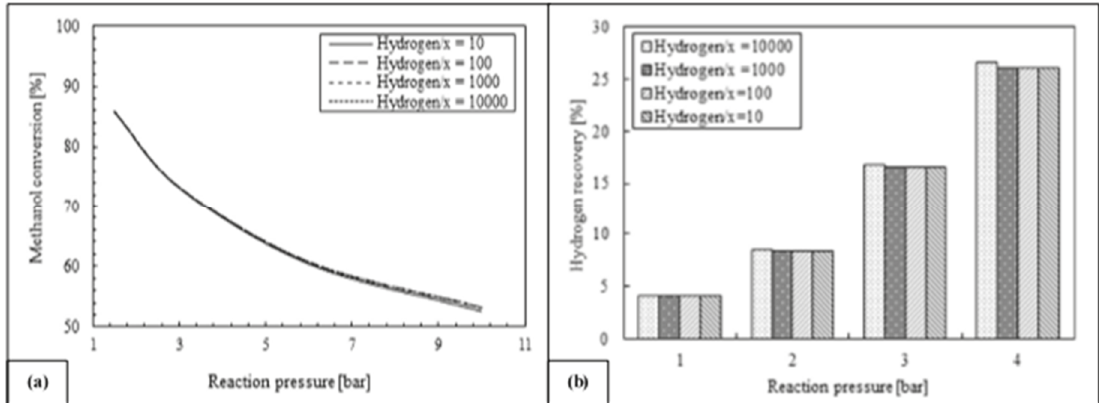
Figure 11. Methanol conversion ( a ) and hydrogen recovery ( b ) vs. reaction pressure at various membrane hydrogen perm-selectivity, 523 K, H 2 O/CH 3 OH = 3, 0.03 ml/min and 10 − 8 order of hydrogen permeance. With permission to reprint from Elsevier by Ghasemzadeh et al. [45].